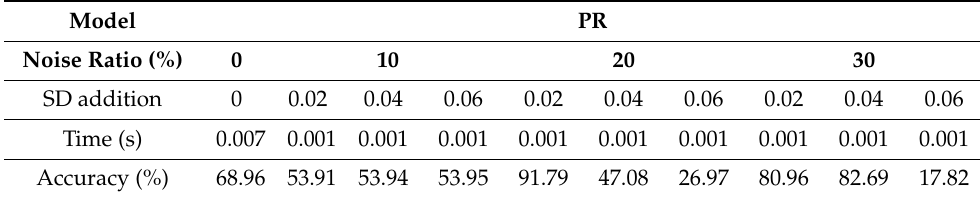
Table 6. Statistical tests of polynomial regression (PR) model.